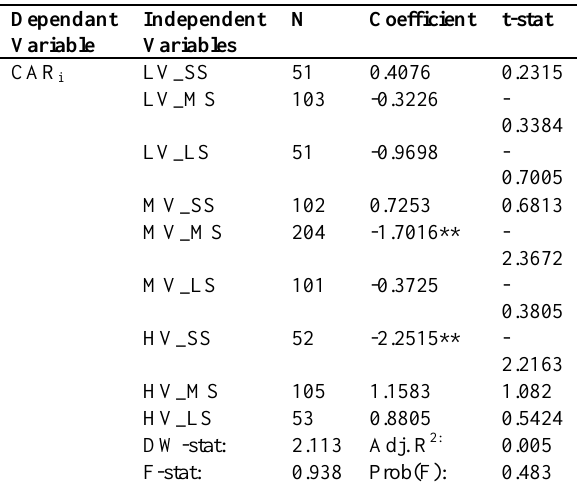
Table 7: Regression result for volatility and size combined